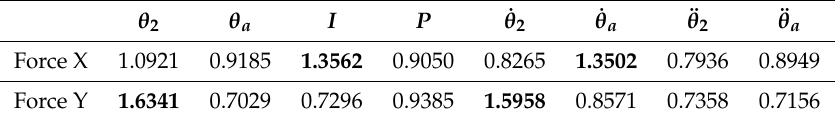
Figure 8. X ( left ) and Y ( right ) real Cartesian forces versus estimated forces using RFR ( top ) and SVR ( bottom ) methods. Table 2. Parameter importance in RFR. The parameters with higher importance are in